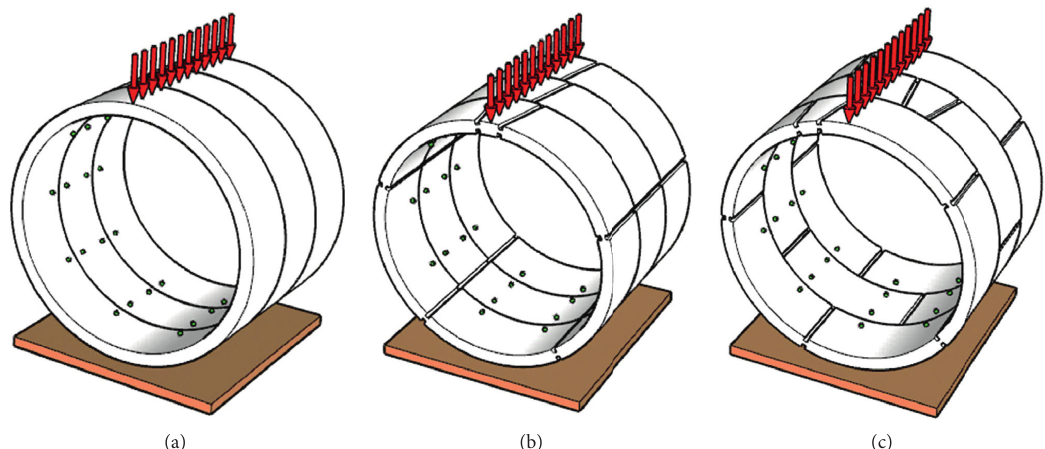
Figure 12: Three types of segmental lining. (a) Uniform rings. (b) Straight-jointed rings. (c) Stagger-jointed rings.